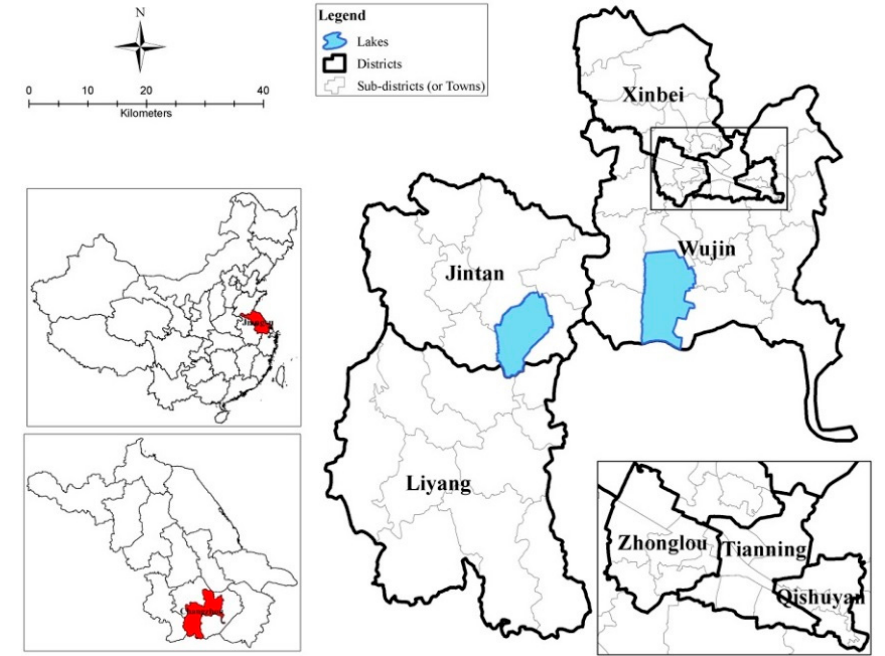
Figure 1. Study area.